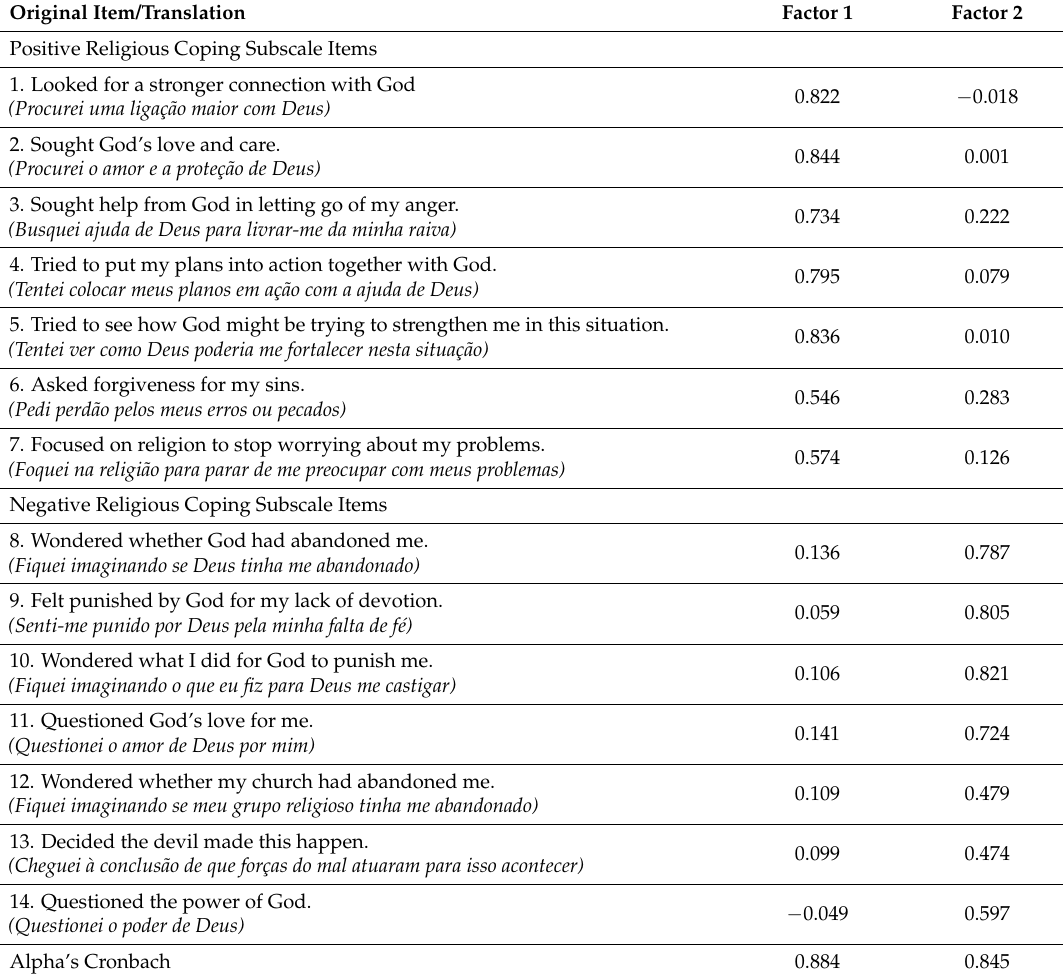
Table 1. Correlation between factors and scale